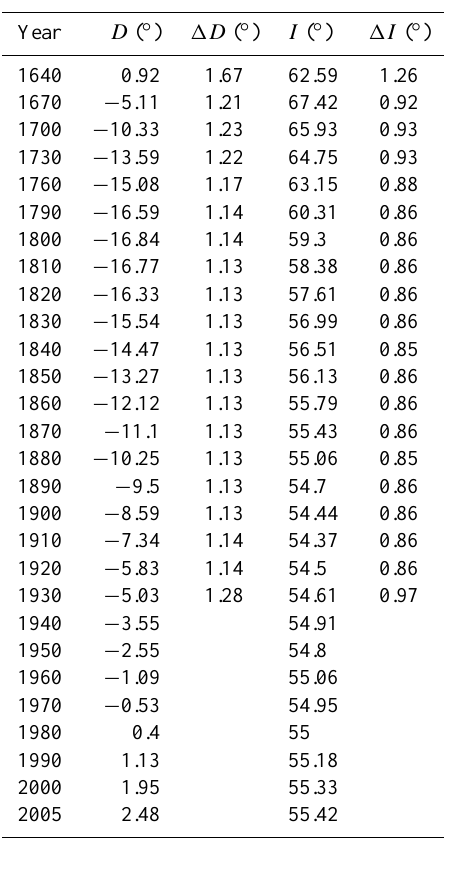
Table 2. Mean directions calculated by means of a 9th polinomyal degree interpolation after having relocated all Italian data to Strom- boli (38.8 ◦ N, 15.26 ◦ E) via pole method, and having corrected the observation years considering a 0.46 ◦ yr − 1 westward drift (see text).